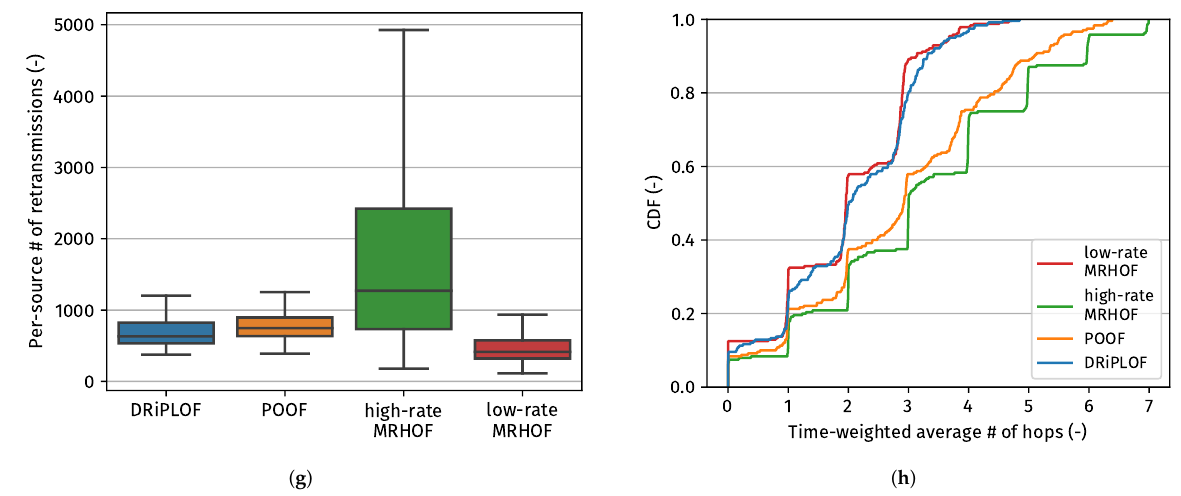
Figure 9. Simulation results for the conditions free of cross-technology interference. ( a ) The end-to- end latency of upward data packets successfully received by the root. ( b ) The number of times a non-root node changed its preferred parent. ( c ) The ratio of data packets processed by the root to the number of T s expiration events. ( d ) The time spent (by a non-root node) detached from the DODAG. ( e ) The energy spent (by a node) transmitting. ( f ) The median transmit energy versus the median packet loss for every simulation run. ( g ) The number of times a non-root node retransmitted a unicast packet. ( h ) Cumulative Distribution Function (CDF) of the time-weighted average path